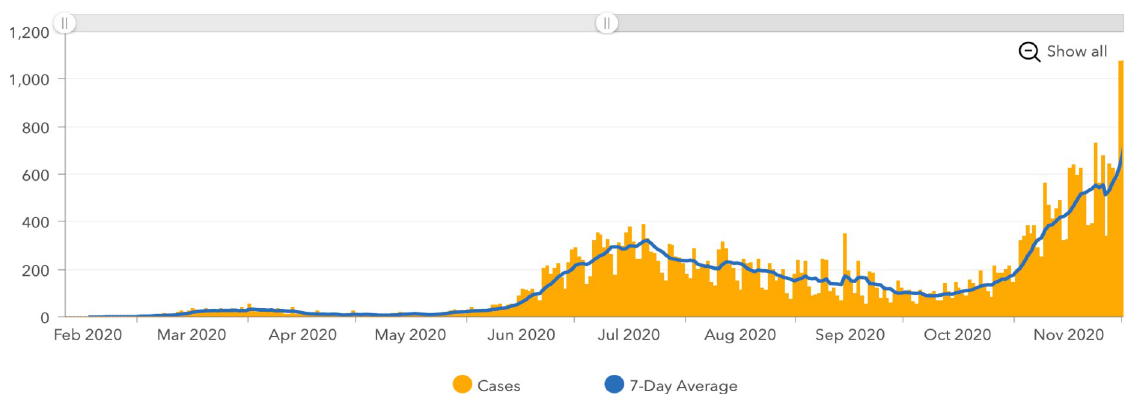
Fig 3. Cases of COVID-19 in Sacramento County, California. These cases are shown from February through November 2020. Included with the permission of the Sacramento County